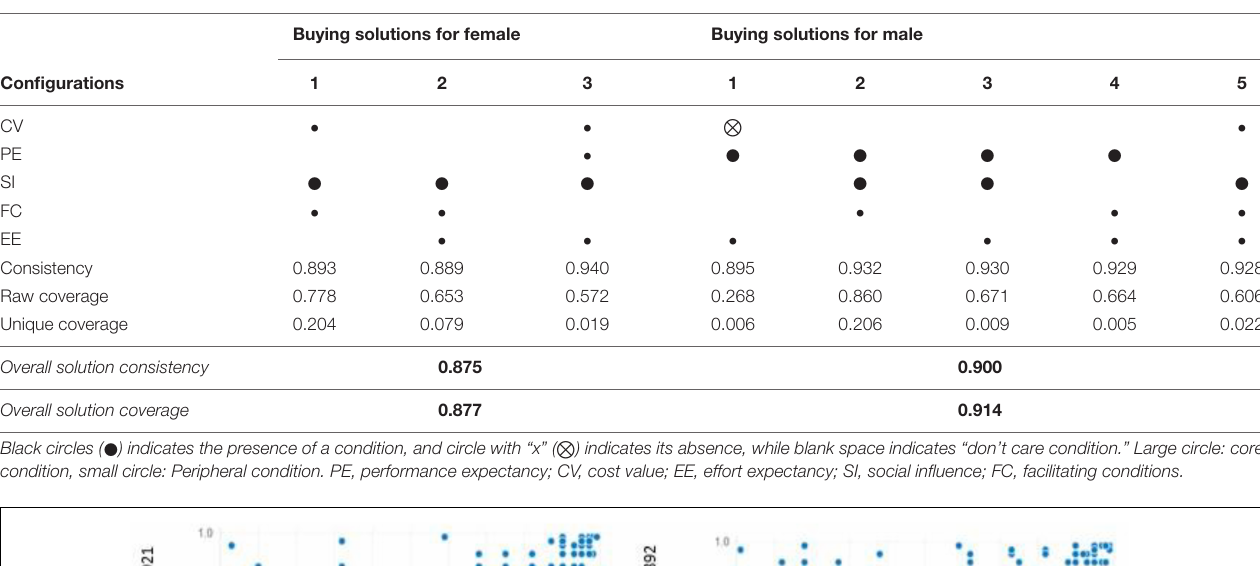
TABLE 8 | Gender-specific solutions to buy smartwatches.